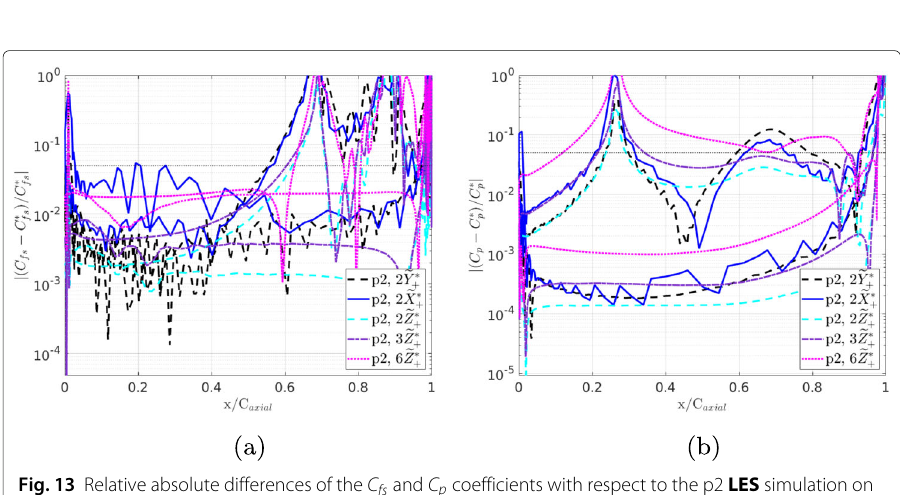
Fig. 13 Relative absolute differences of the C fs and C p coefficients with respect to the p2 LES simulation on the coarse mesh. Note that the horizontal dotted line marks the 5% difference threshold. a |(cid:8) C fs | . b |(cid:8) C p